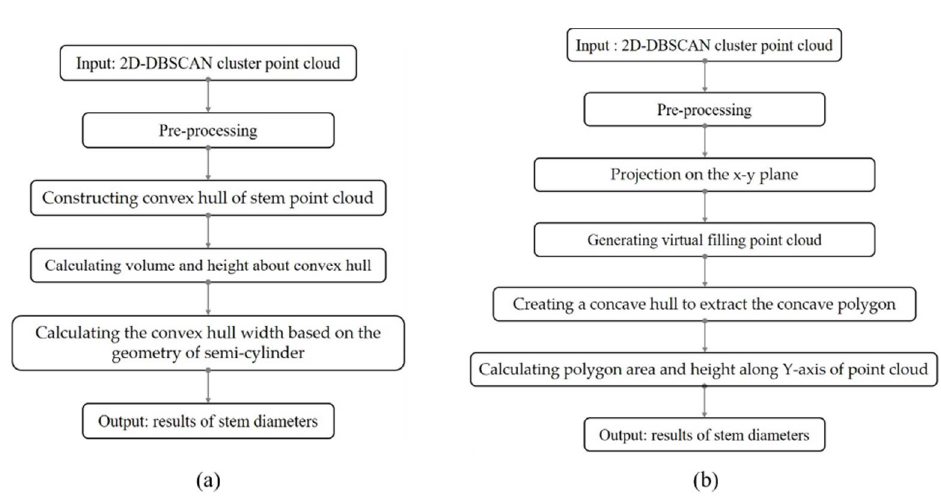
Figure 6. Two approaches for estimating the stem diameters. ( a ) SD-PCCH; ( b ) SD-PPC. SD-PCCH estimates the stem diameters by constructing a convex hull. The convex